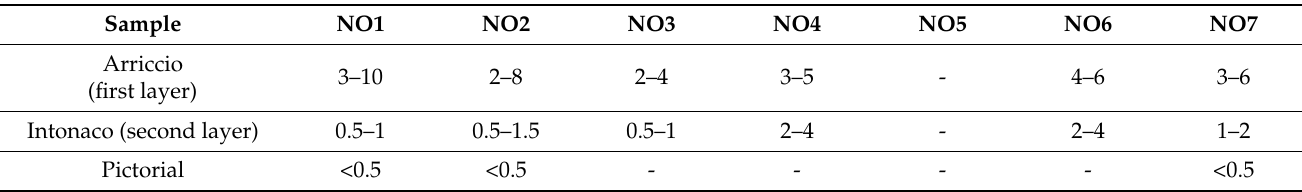
Table 3. Microstratigraphy of the samples (thickness in